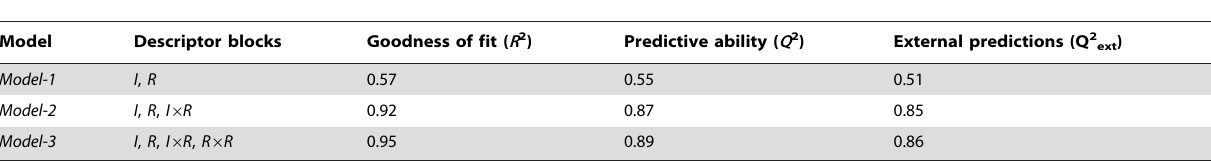
Table 1. Performance of proteochemometric models for prediction of HIV-1 RT drug